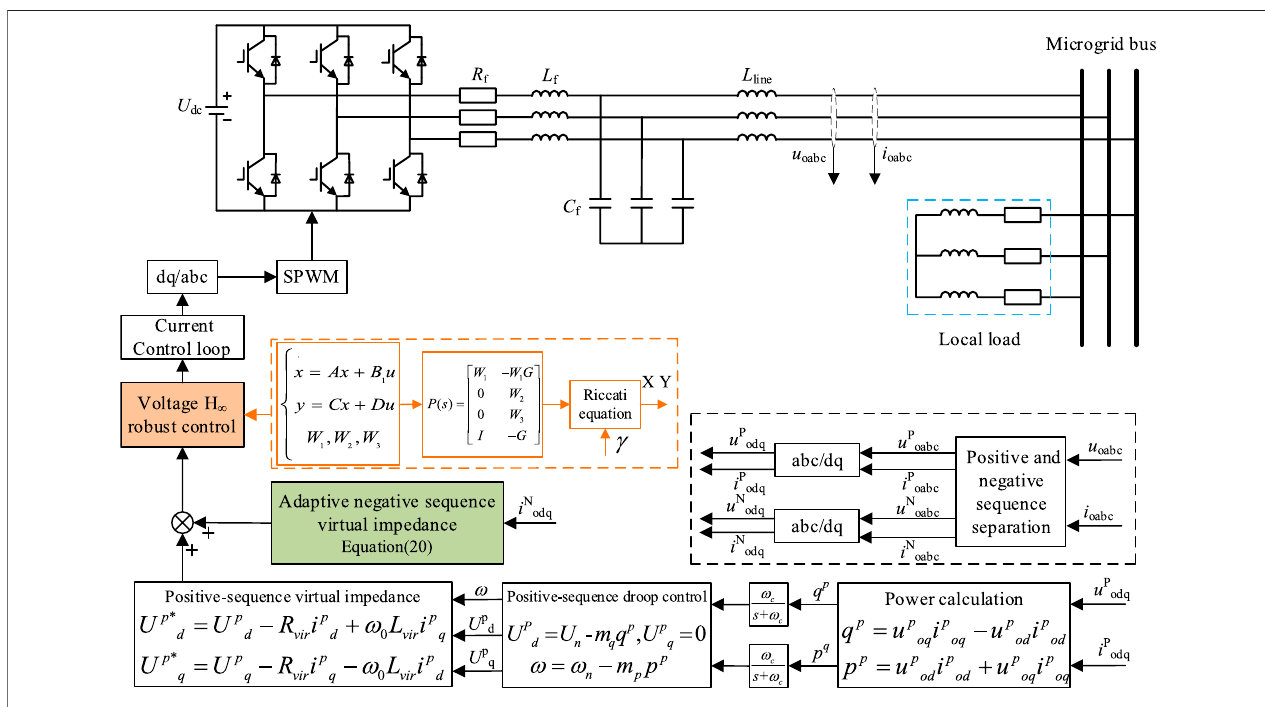
FIGURE 7 | Proposed control scheme of H ∞ control for VSI.